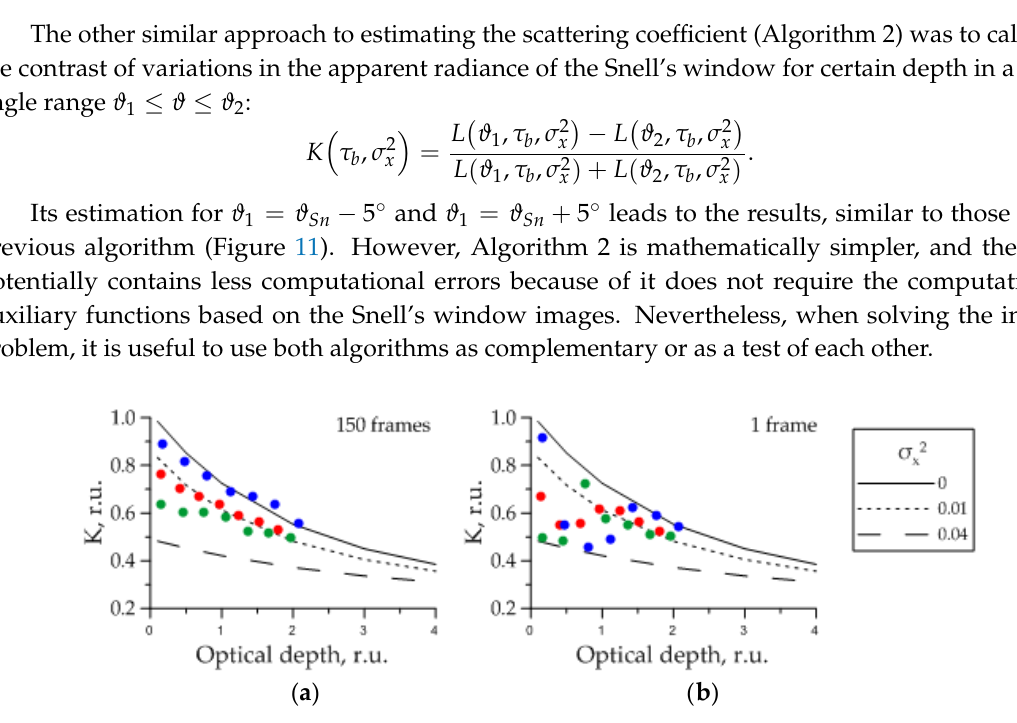
Figure 11. The comparison of theoretical values of parameter K with its empirical values obtained by ( a ) 150 frames and ( b ) one frame of the Snell ’ s window in each color filter: 420 nm (blue points), ( a ) 150 frames and ( b ) one frame of the Snell’s window in each color filter: 420 nm (blue points), 530 530 nm (green points) and 650 nm (red points). nm (green points) and 650 nm (red